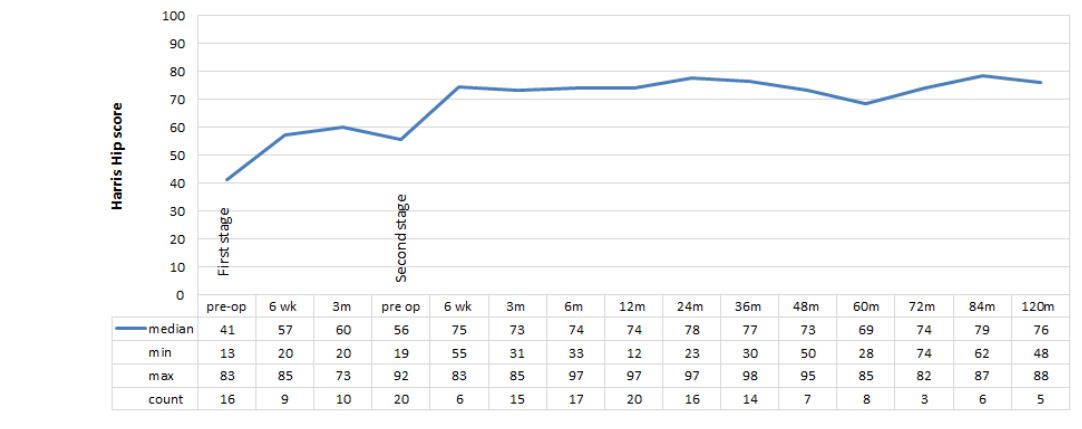
Figure 2. Harris Hip Scores. HHS: poor < 70, fair 70–79, good 80–89, and excellent 90–100. The median post-operative pain score improved to 40 (range 0–44) at 12 months, 44 (range 10–44) at 24 months and 44 (range 30–44) at 120 months following last revision (Figure 3). After the last revision, there was a significant improvement in pain at 12 months relative to that recorded pre-operatively ( p = 0.046).